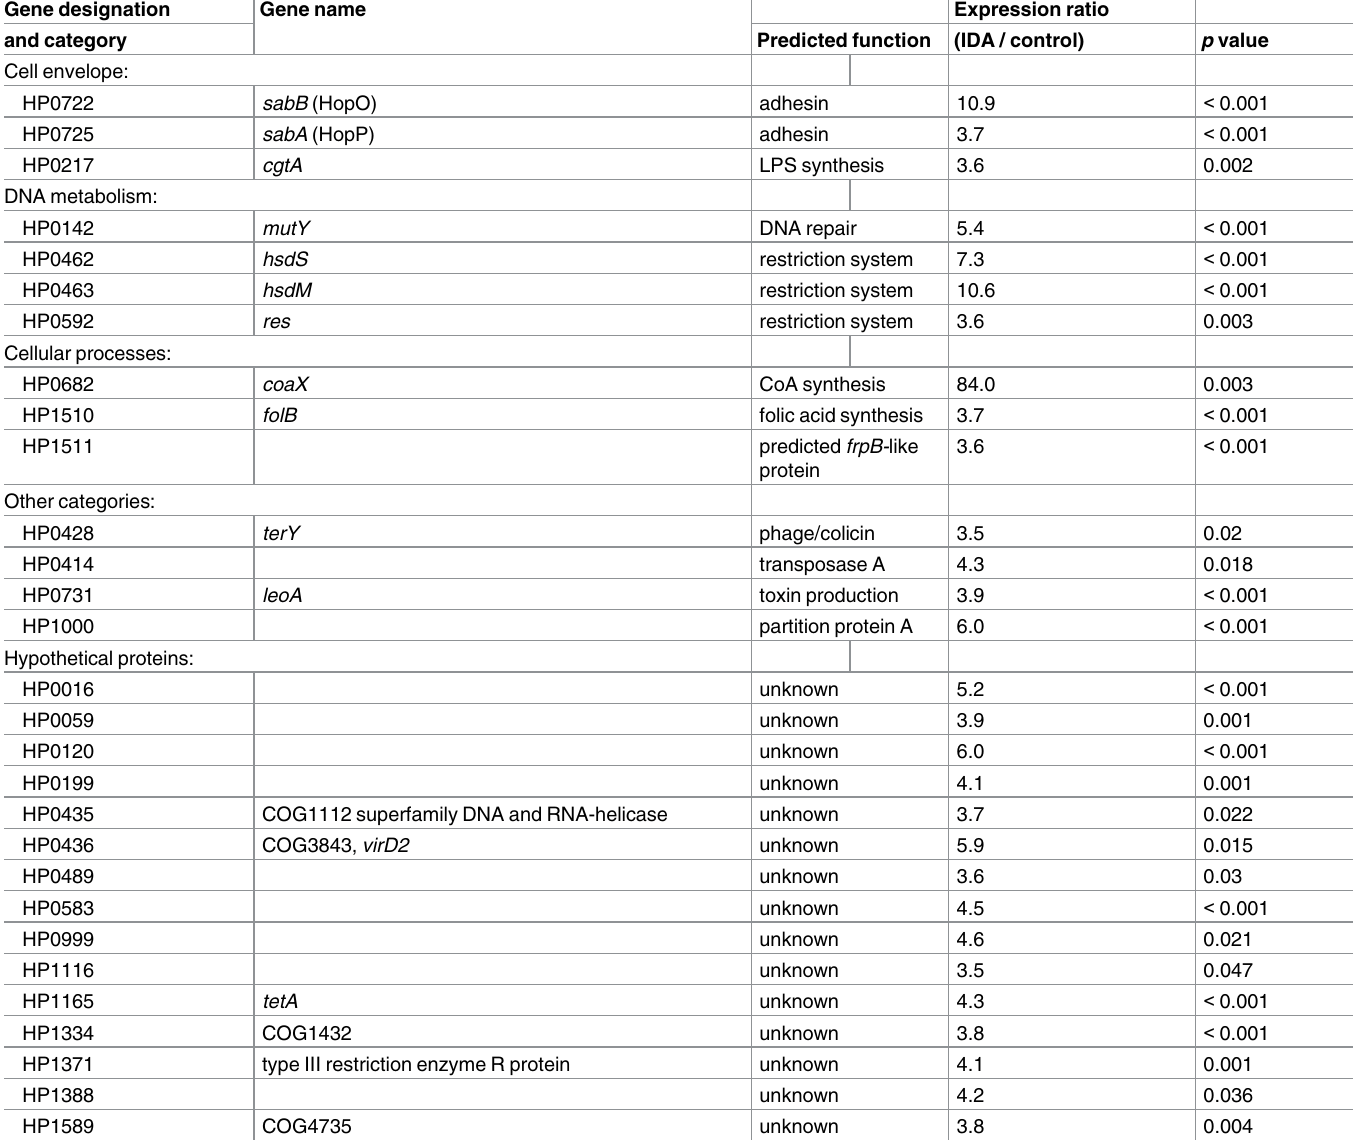
Table 3. H . pylori genes with higher expression a in IDA